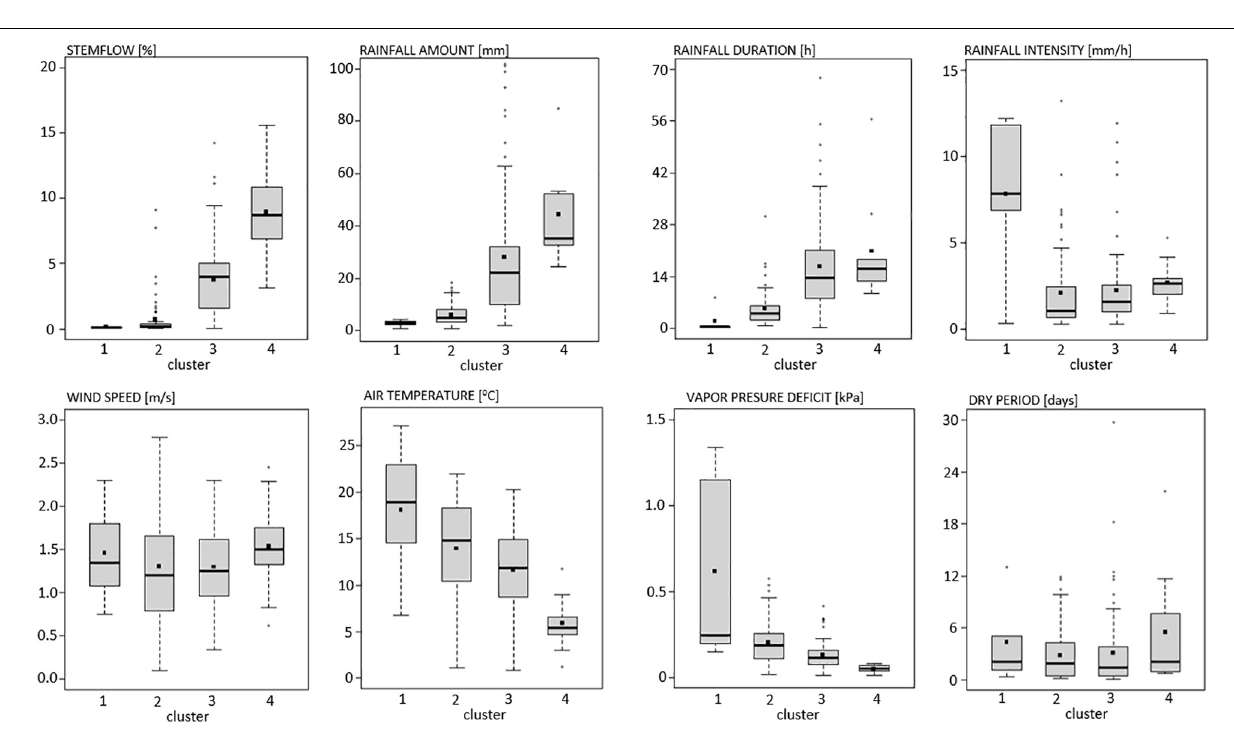
Frontiers in Forests and Global Change |